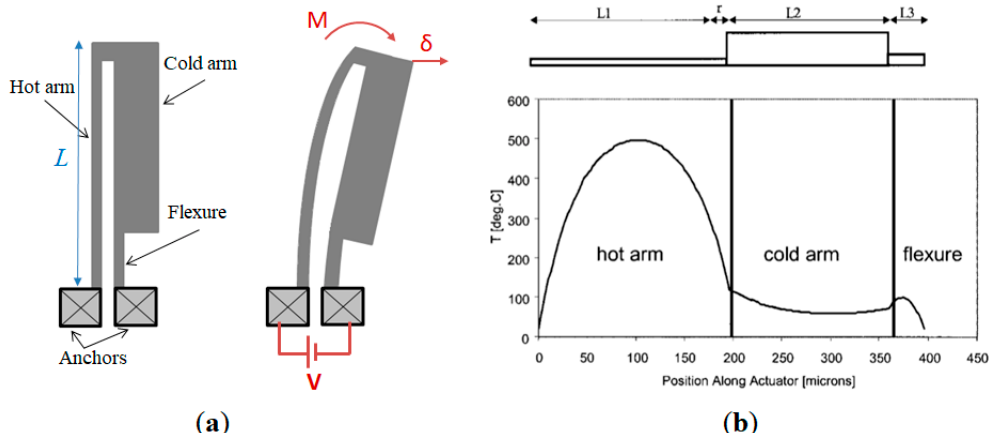
Figure 1. U-shaped hot-and-cold-arm actuator: ( a ) principle; ( b ) steady-state temperature profile along the actuator [16].